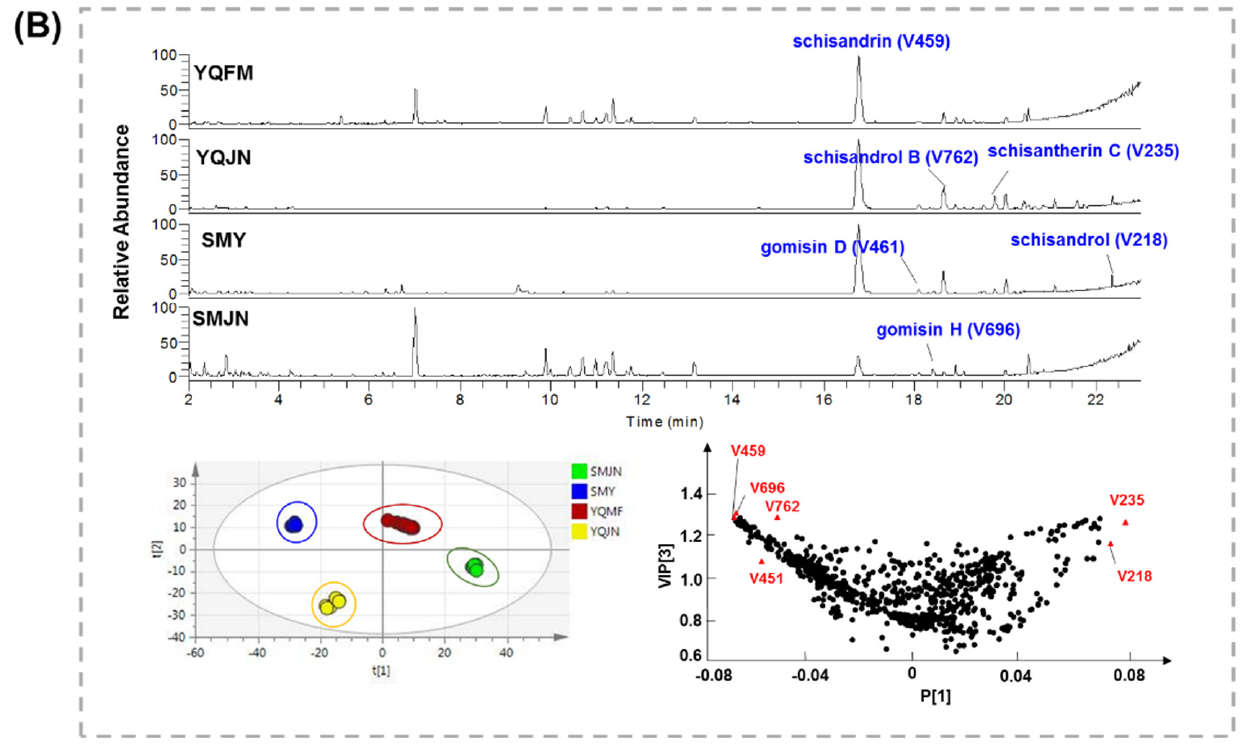
Figure 2. The LC/MS chromatograms of SMS-based patent drugs along with PCA results and variable importance in projection (VIP) plots. ( A ) Negative ion mode; ( B ) positive ion mode.